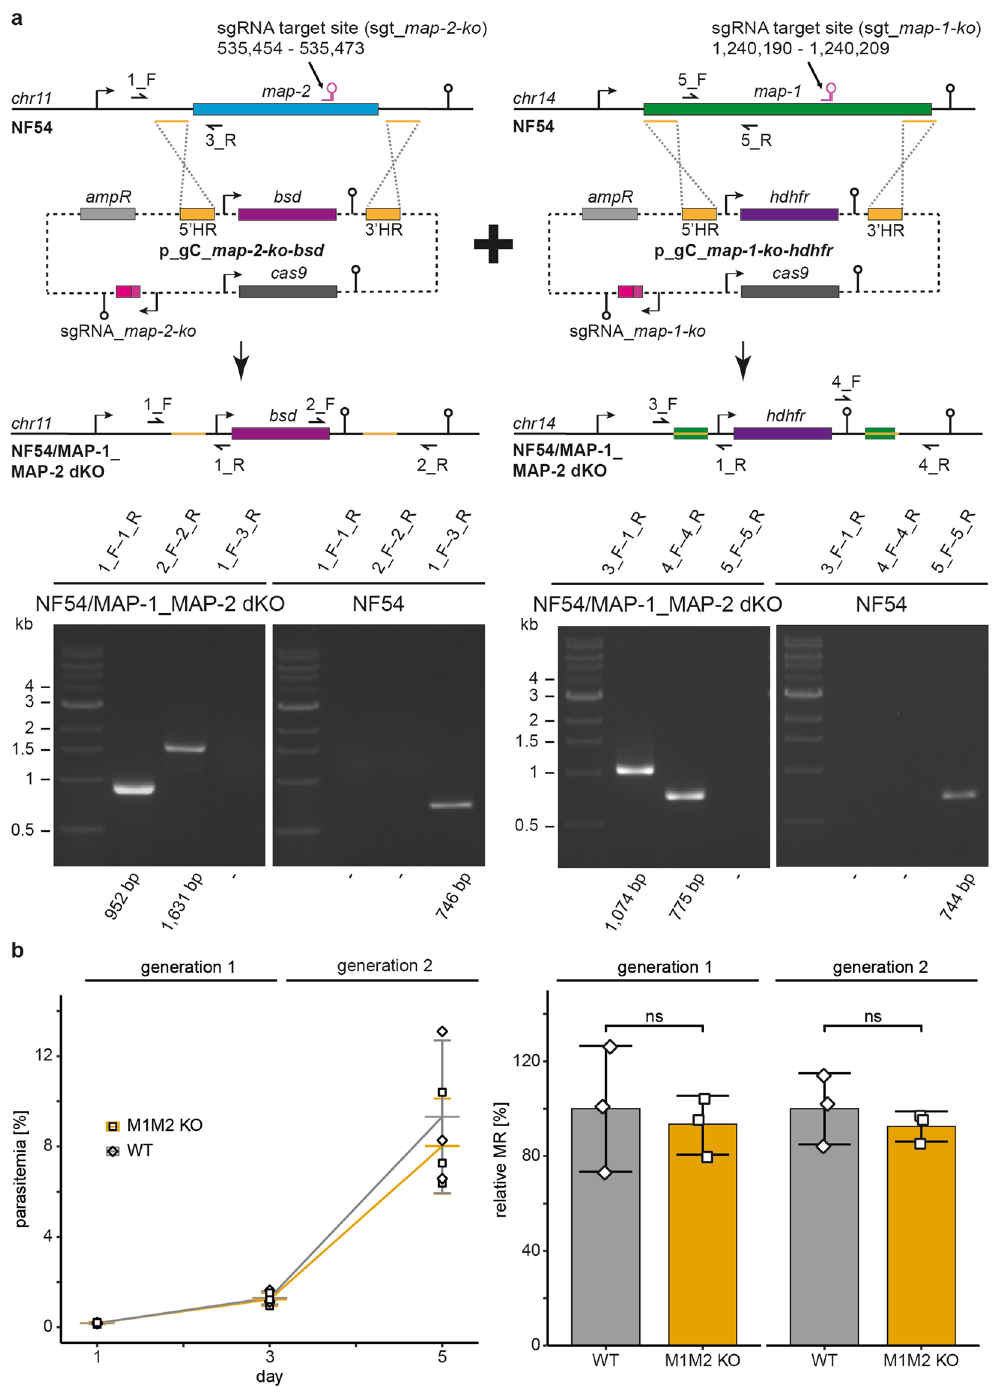
Figure 1. Engineering and growth assay of the MAPK double KO parasite line. ( a ) Top: Scheme depicting the CRISPR/Cas9-based gene editing approach used to generate the NF54/MAP-1_MAP-2 dKO parasite line. Schematic maps of the pfmap-2 locus and the CRISPR/Cas9 p_gC_ map-2-ko-bsd plasmid used to generate the NF54/MAP-2 KO line (left), that was re-transfected using the p_gC_ map-1-ko-hdhfr plasmid to generate the NF54/MAP-1_MAP-2 dKO parasite line (right). Bottom: PCRs performed on gDNA of NF54/MAP-1_MAP-2 dKO parasites show correct editing of both mapk loci. PCRs performed on NF54 WT gDNA serve as controls. ( b ) Left: Flow cytometry data showing the increase in parasitemia of NF54 WT and NF54/MAP-1_MAP-2 dKO parasites over two generations. Right: Multiplication rates quantified from flow cytometry data in NF54 WT and the NF54/MAP-1_MAP-2 dKO parasites in both generations. Values show the means ± SD of three biological replicates with individual data points represented by open squares. ns, not significant (unpaired two-tailed Student’s t test); MR, multiplication rate; WT, NF54 WT; M1M2 KO, NF54/MAP-1_MAP-2